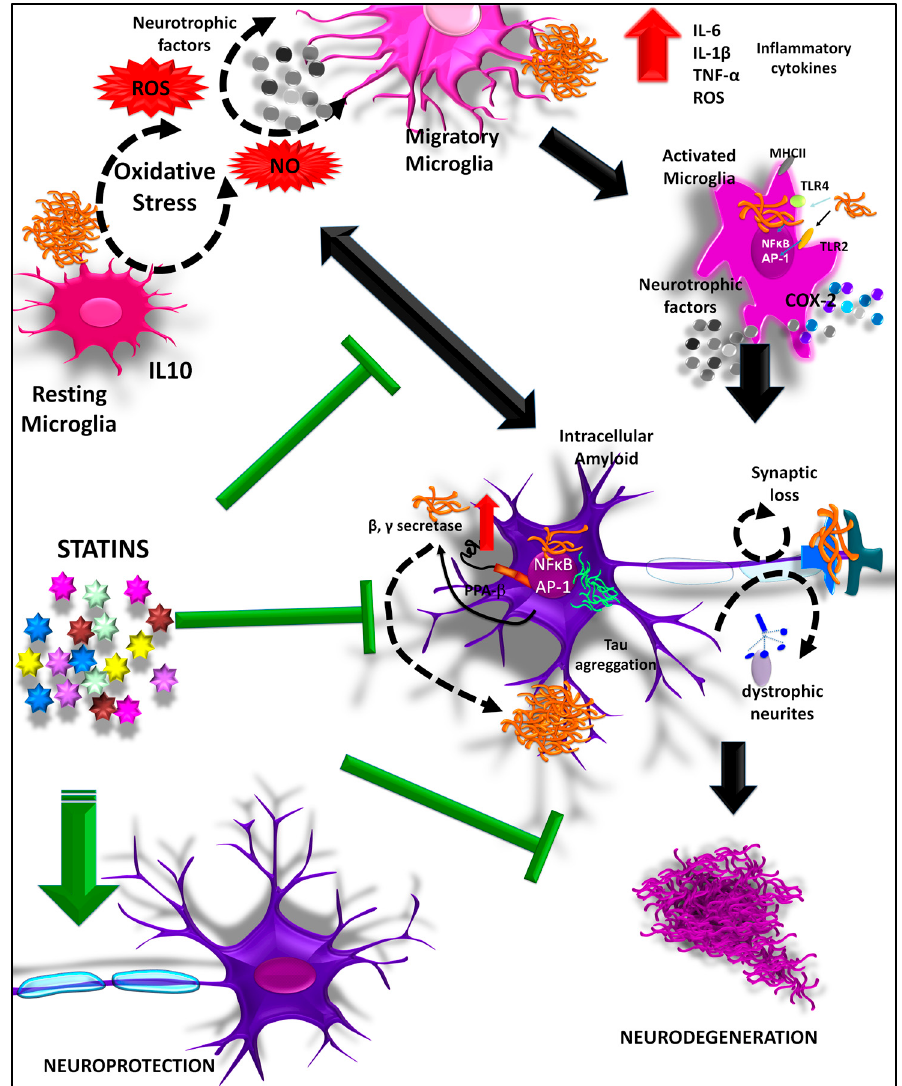
Figure 5. Neuroprotective effect of statins. Statins attenuate neuronal damage caused by A β , con- ducting to decreased A β levels and A β aggregation. A β induces tau hyperphosphorylation through activation of GSK3 β , leading to neuronal death. Statin also can reduce A β -induced neuronal apop- tosis, as well as the inflammatory processes that lead to neurodegeneration, increasing neuropro- tection.